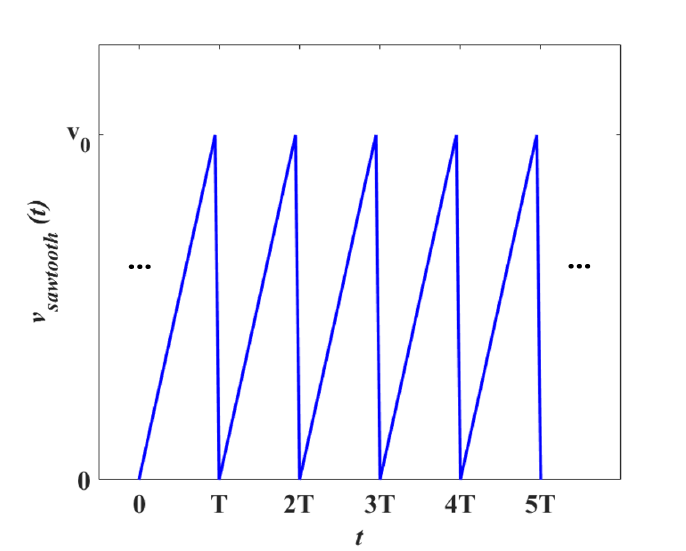
Figure 3. Waveform fo the periodic sawtooth wave